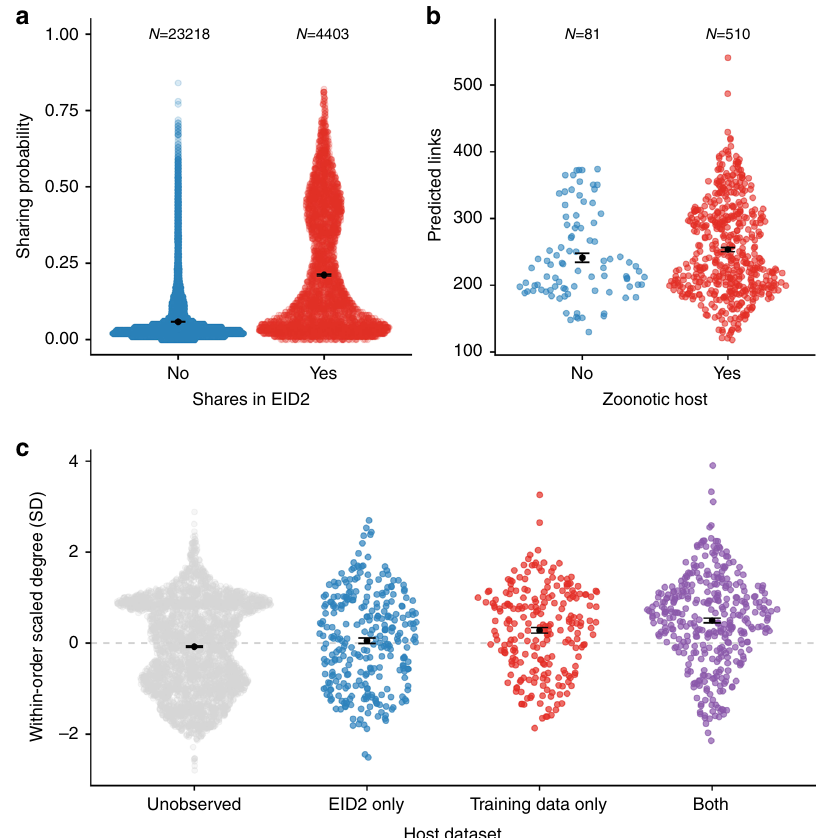
Fig. 2 The predicted viral sharing network predicts observed trends in an independent dataset. In all fi gures, points are jittered along the x- axis according to a density function; the black points and associated error bars are means ± standard errors. a Species pairs with higher predicted viral sharing probability from our model were more likely to be observed sharing a virus in the independent EID2 dataset. This comparison excludes species pairs that were also present in our training data. b Species that hosted a zoonotic virus in our dataset had more viral sharing links in the predicted all-mammal network than those without zoonotic viruses. c Species that had never been observed with a virus have fewer links in the predicted network than species that were known to host viruses in the EID2 dataset only, in our training data only, or in both. The y -axis represents viral sharing link number, scaled to have a mean of 0 and a standard deviation of 1 within each order for clarity. Black points represent means; error bars represent standard errors. Supplementary Figure 5 displays these same data without the within-order